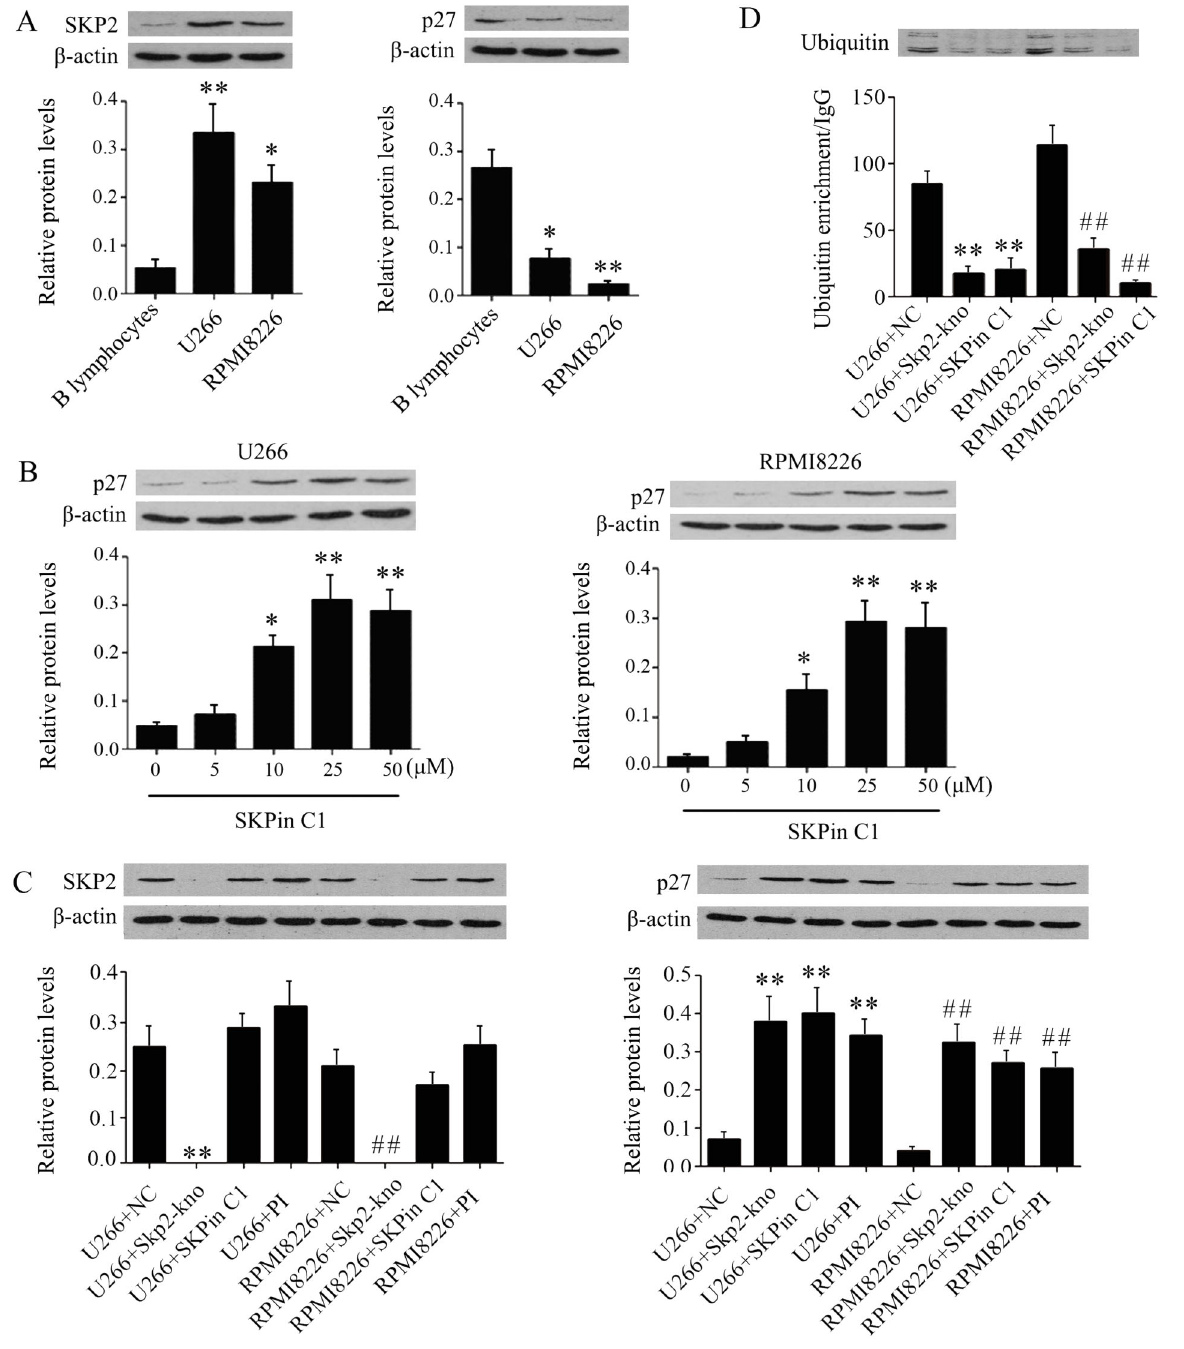
Figure 3 . SKPin C1 increased p27 protein levels in U266 and RPMI 8226 cells by inhibiting ubiquitination, evaluated by western blot assay. A , Protein levels of SKP2 and p27 in U266 and RPMI 8226. B , Intracellular p27 protein levels in U266 and RPMI 8226 cells exposed to different dosages of SKPin C1. C , Protein levels of SKP2 and p27 in U266 and RPMI 8226 cells treated with 25 m M of SKPin C1 or 25 m M of bortezomib, or transfected with the siRNA that targeted SKP2. D , U266 and RPMI 8226 cells were treated with 25 m M of SKPin C1, or transfected with the siRNA targeted SKP2. The amount of ubiquitin protein combined to p27 was determined using an immunoprecipitation assay. Data are reported as means ± SD. *P o 0.05 and **P o 0.01 vs control group of U266 cells; ## P o 0.01 vs control group of RPMI 8226 cells (ANOVA). SKP2-kno: SKP2 knockdown; PI: proteasome inhibitor, namely